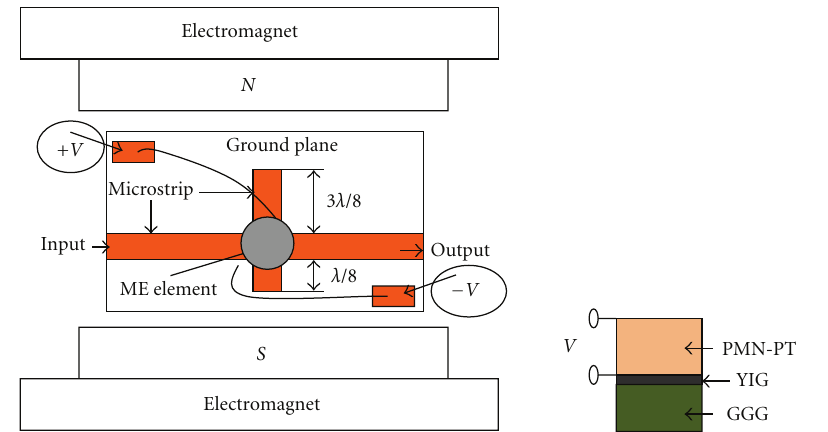
Figure 8: Schematics of a ME microwave phase shifter and ME resonator of YIG film on GGG bonded to PMN-PT.